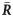
Influences of minimal thickness t and beam length L on fatigue reliability R¯.(A) Minimal thickness and (B) Beam length.